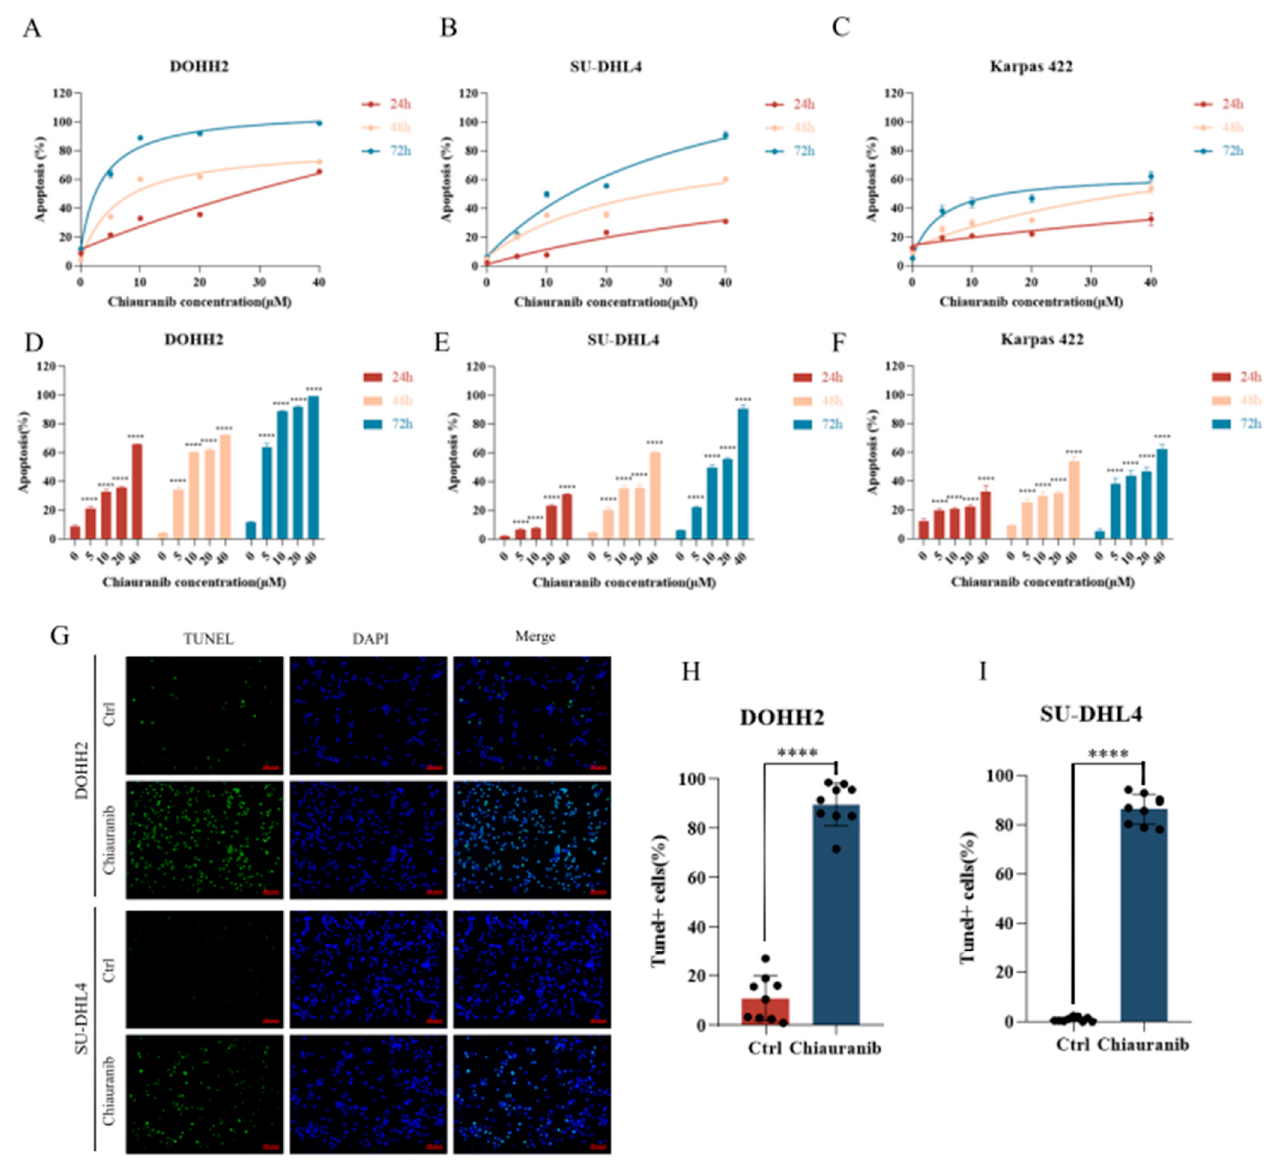
Figure 2. Chiauranib induced apoptosis of t-FL cells. The double staining of Annexin V and PI for cell apoptosis in ( A ) DOHH2, ( B ) SU-DHL4, and ( C ) Karpas422 cells. The statistical graph is shown for ( D ) DOHH2, ( E ) SU-DHL4, and ( F ) Karpas422. P-values represented by asterisks in the graphs represent statistically significant differences between each chiauranib concentration and vehicle control. ( G ) After treating with 40 µM chiauranib, the results of the TUNEL assay of DOHH2 and SU-DHL4 are photographed (proportional scale 1:100 pixel). Data from at least three independent experiments are shown for ( H ) DOHH2 and ( I ) SU-DHL4 (**** p <